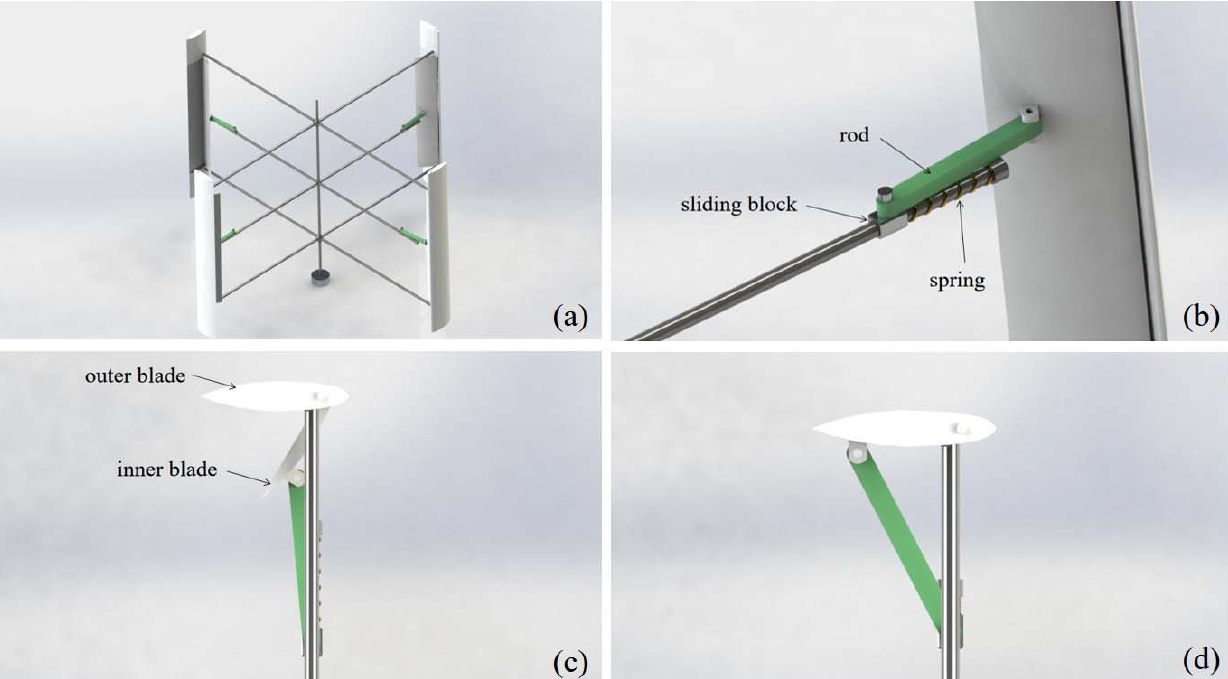
Figure 1. Impeller structure design drawing: ( a ) overall structure top view, ( b ) adaptive extension